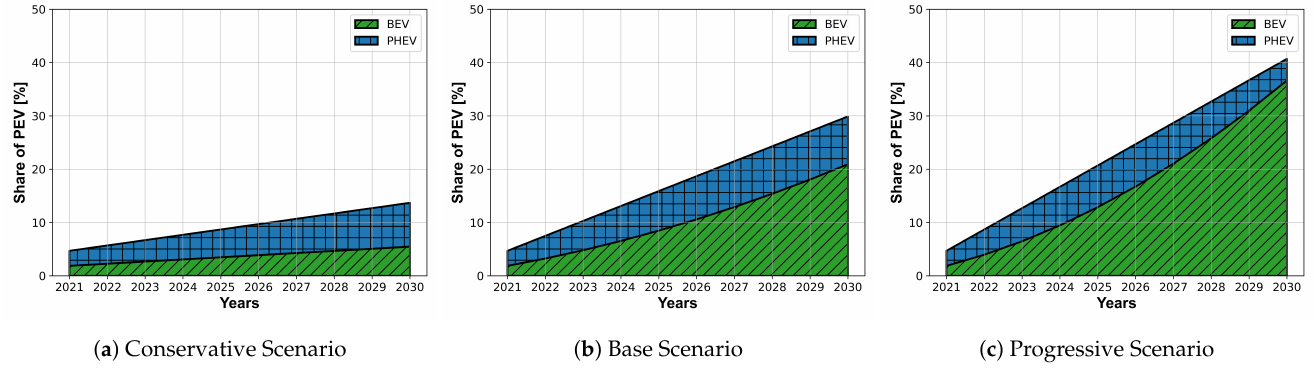
Figure 4. Scenarios for the Ramp Up of Plug-in Electric Vehicles in the Study